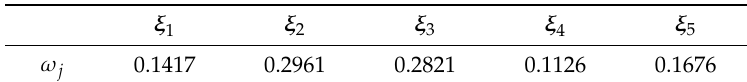
Table 9. Weights of